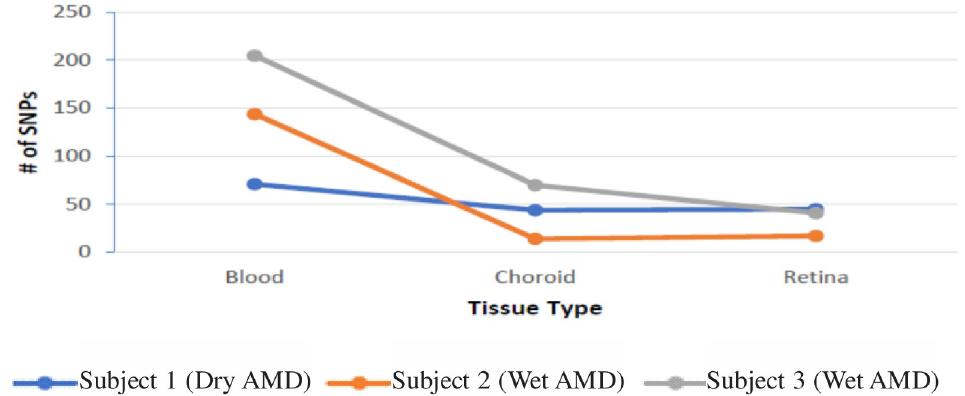
Fig 1. Number of SNPs for subjects and tissue